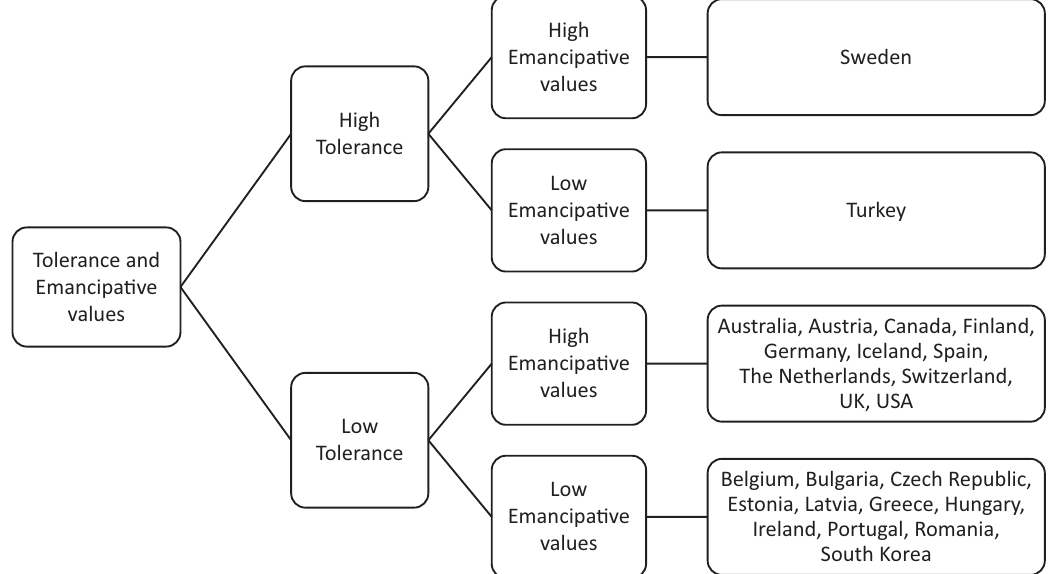
Figure 4. Four clusters of the press based on emancipative values and journalists’ perception of their role as promoting tolerance and cultural